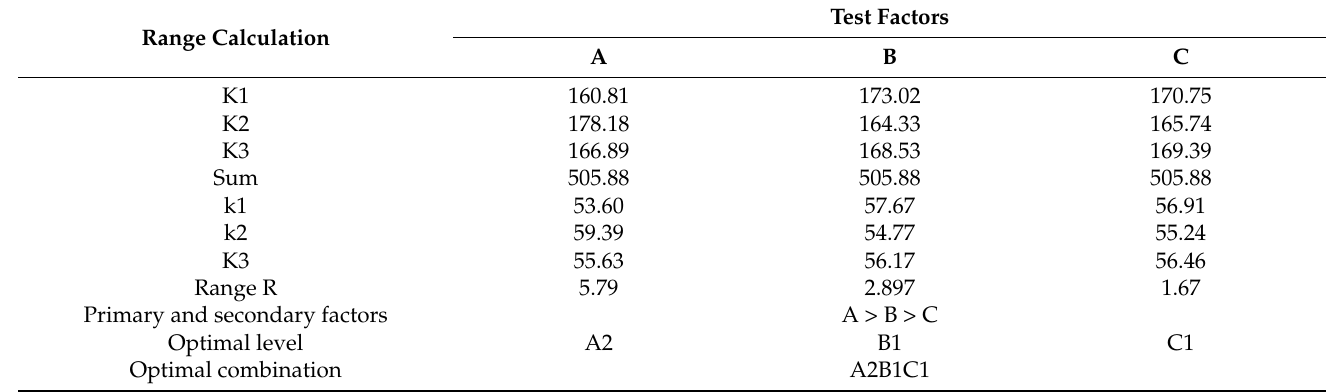
Table 8. Range analysis results of compression test of perforated steel sheet